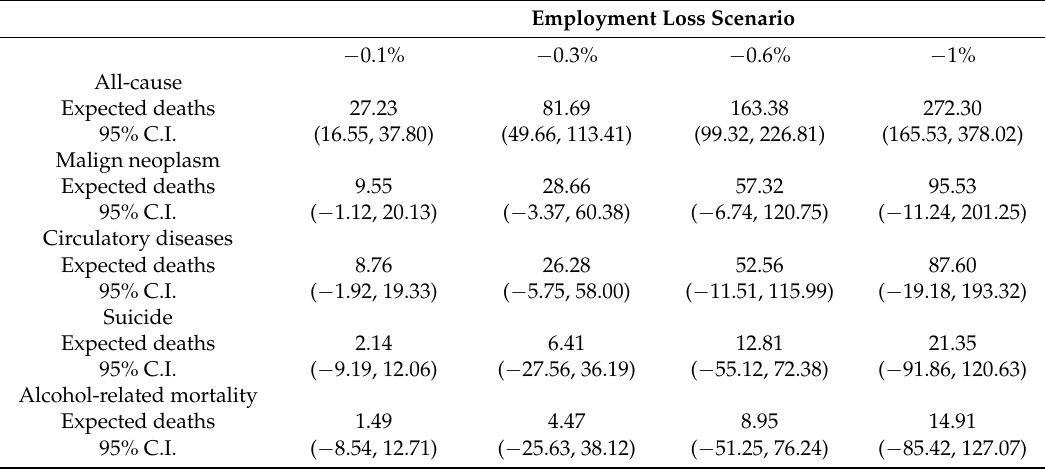
Table 4. Monte-Carlo simulation results: impact of job loss on different causes of mortality, in terms of expected number of deaths in 4 years following the job